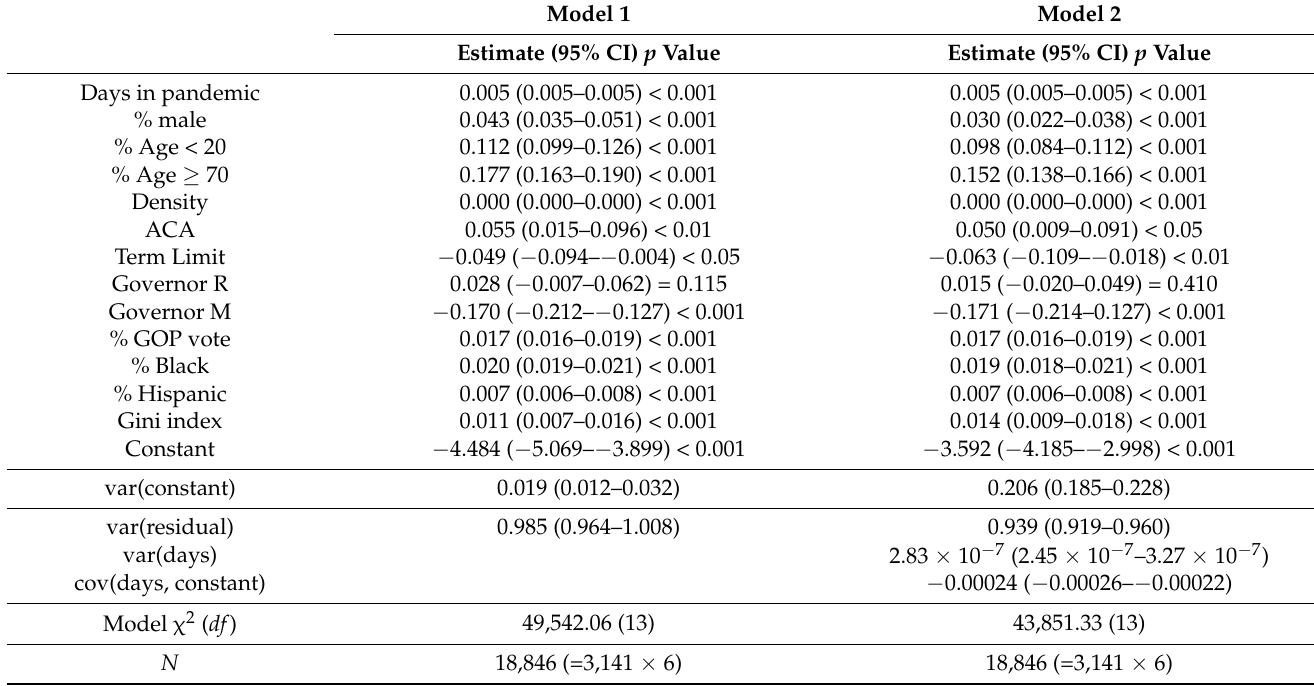
Table 3. Estimates from Growth Curve Models of Mortality Rates over 900 Days of the Pandemic in 3,141 US Counties. Model 1 Model 2 Estimate (95% CI) p Value Estimate (95% CI) p